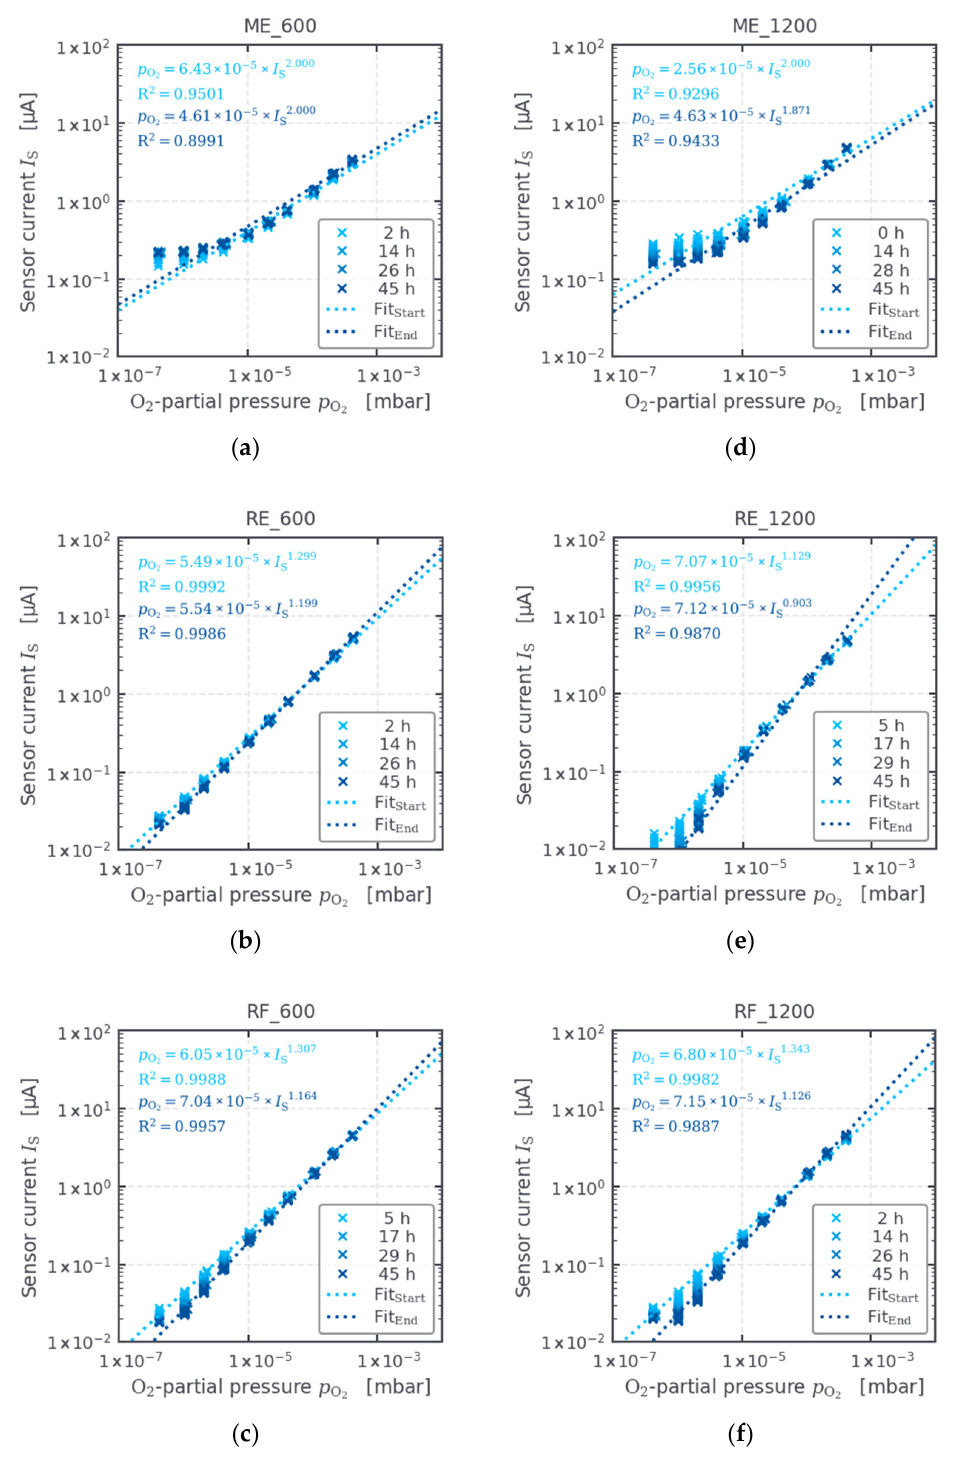
Figure 7. Characteristic curves of the sensors manufactured using the YSZ thin films as solid-state electrolyte after the thermal annealing treatment at 600 and 1200 °C: ( a , d ) DC-metallic; ( b , e ) DC- reactive; and ( c , f ) RF-oxide. The Y-axes are presented in logarithmic scale. The current drift over the time is represented by the (blue) color scale.